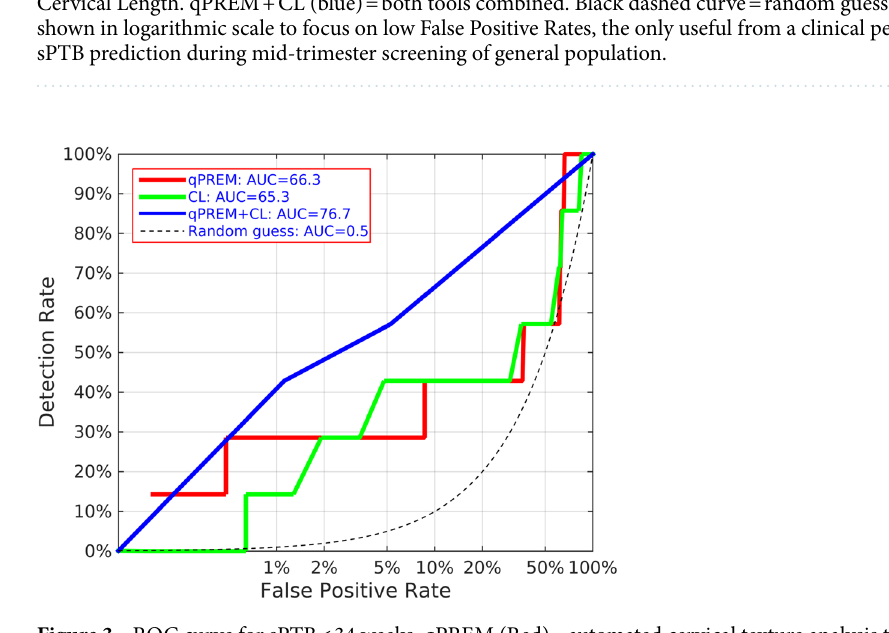
Figure 3. ROC curve for sPTB < 34 weeks. qPREM (Red) = automated cervical texture analysis tool. CL (Cyan): Cervical Length. qPREM + CL (blue) = both tools combined. Black dashed curve = random guess. X axis is shown in logarithmic scale to focus on low False Positive Rates, the only useful from a clinical perspective for sPTB prediction during mid-trimester screening of general